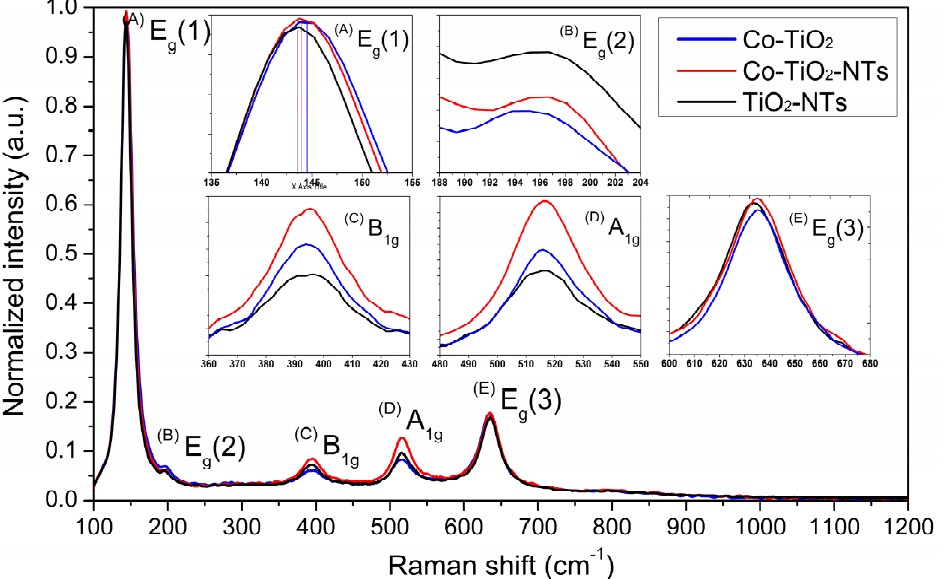
Figure 3. Raman spectra of pure titania nanotubes and Co-doped TiO 2 samples. ( A – E ) typical modes of the anatase phase.